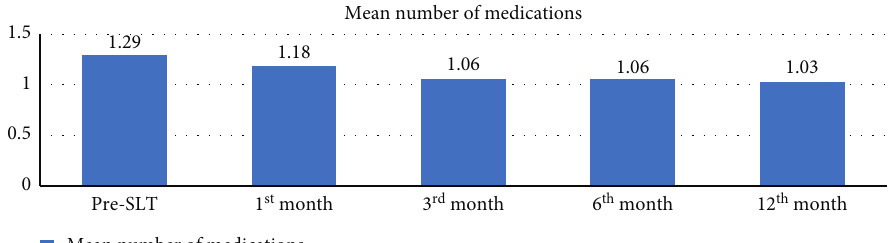
Figure 1: The mean number of medications used before and after SLT, Menelik II Hospital,